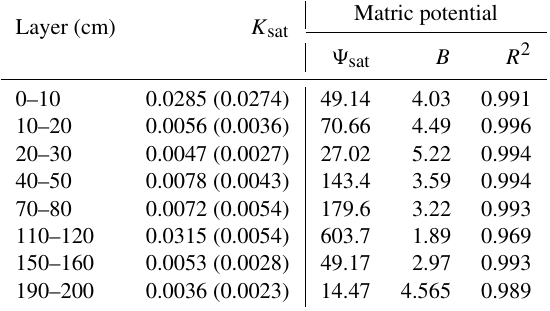
Table 4. The mean (standard deviation) of measured saturated hy- draulic conductivity ( K sat ; mms − 1 ) and fitted absolute value of saturated matric potential ( (cid:57) sat ; mm), fitted pore size distribution parameter ( B ), and the correlation coefficients ( R 2 ) between calcu- lated matric potential using fitted and measured